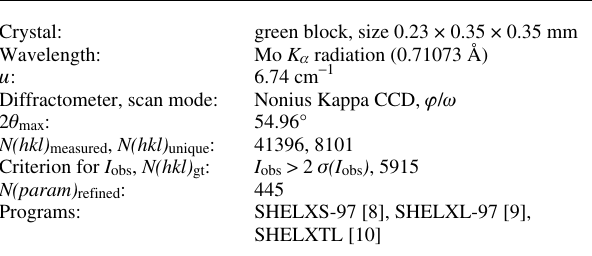
Table 1. Data collection and